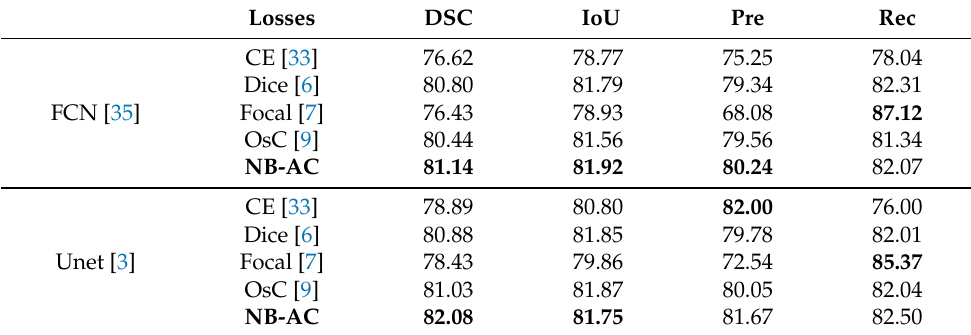
Table 1. Comparison between our proposed NB-AC loss against other losses CE [33], Dice [6], Focal [7], and OsC [9] on the DRIVE dataset with the corresponding two network backbones 2D- FCN [35] and 2D-Unet [3]. The best performance is shown in bold .